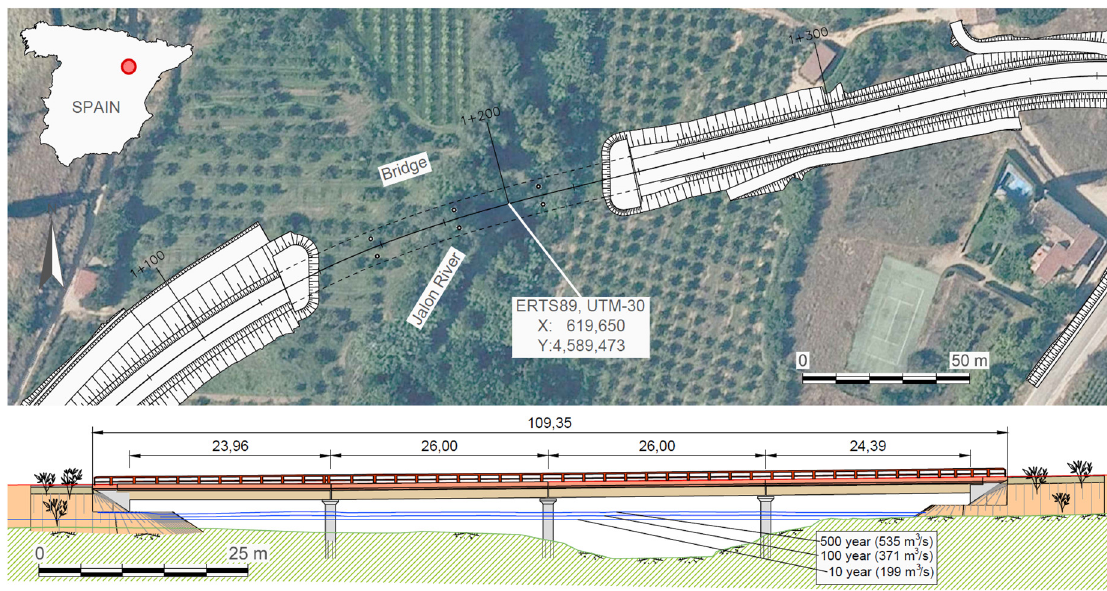
Figure 1. Road crossing on the Jalón River in Sabiñán (Spain), with a four-span bridge.